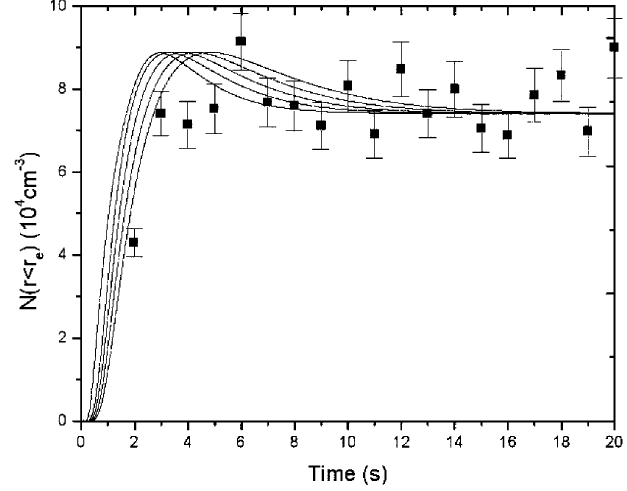
FIG. 6. The simulation results for the evolution of H-like Mo ions inside the EBITwith machine parameters as described in the main text. The evolutions are calculated using different values for the beam radius. The lines (from slowest to fastest onset) correspond to a beam radius of 66, 62, 58, 52, and 48 (cid:8) m , respectively. The symbols ‘‘ j ’’ are the experimental data with the errors being determined